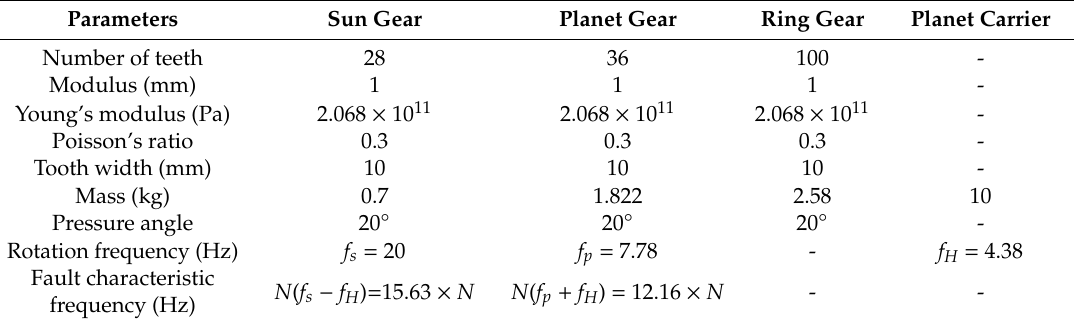
Table 1. Dynamic simulation parameters of the planetary gear